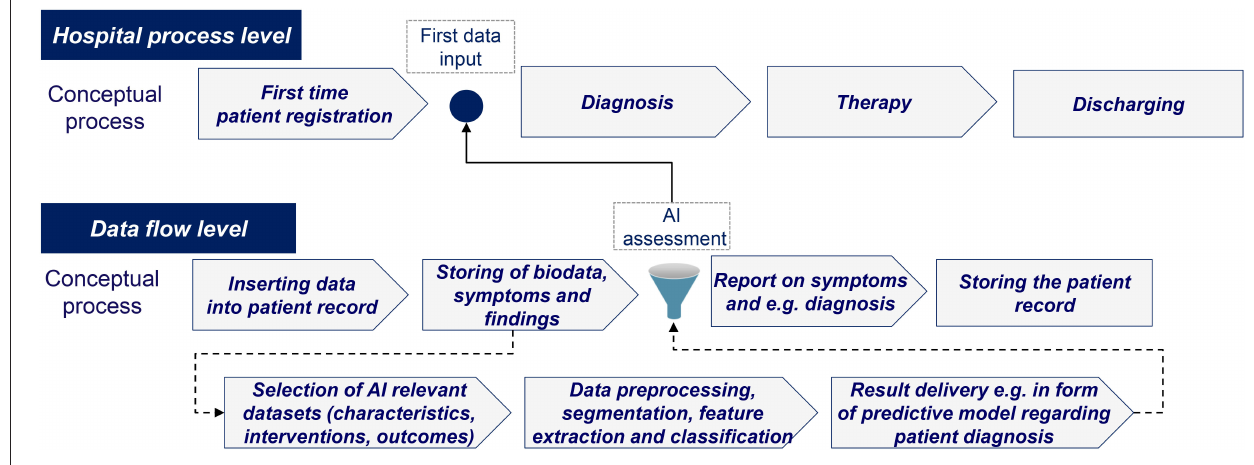
FIGURE 4 | AI integration into routine healthcare processes (authors).